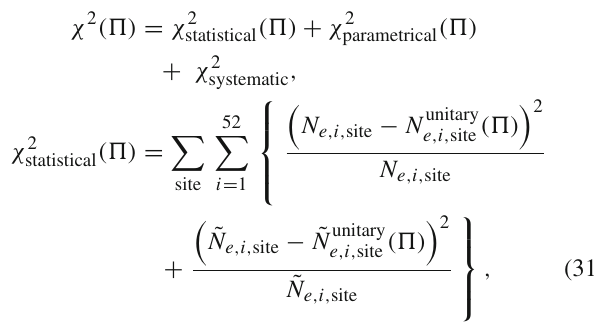
for a plan of the T2HK plus a 10 kton water Cerenkov detector at Kamioka. { min χ 2 ( wrong H ) − min χ 2 ( true H ) } = 4 , 16 , 36 on the redsolid,bluedashed,andpurpledot-dashedcontours,respectively,and { min χ 2 ( wrong H ) − min χ 2 ( true H ) } = 18 2 , 19 2 , 20 2 on the green, brown, and orange dot-dashed contours, respectively. The black-filled regions are where the wrong mass hierarchy is favored over the true mass hierarchy, i.e., min χ 2 ( wrong H ) − min χ 2 ( true H ) <